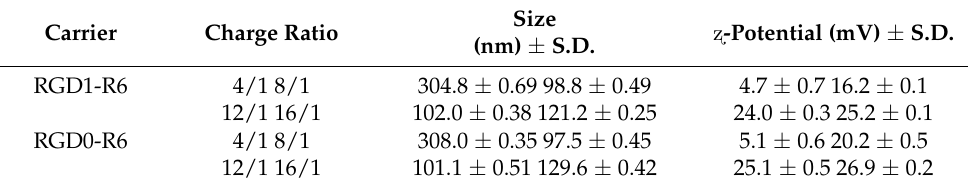
Table 2. Size and zeta-potential of the carrier/DNA complexes.